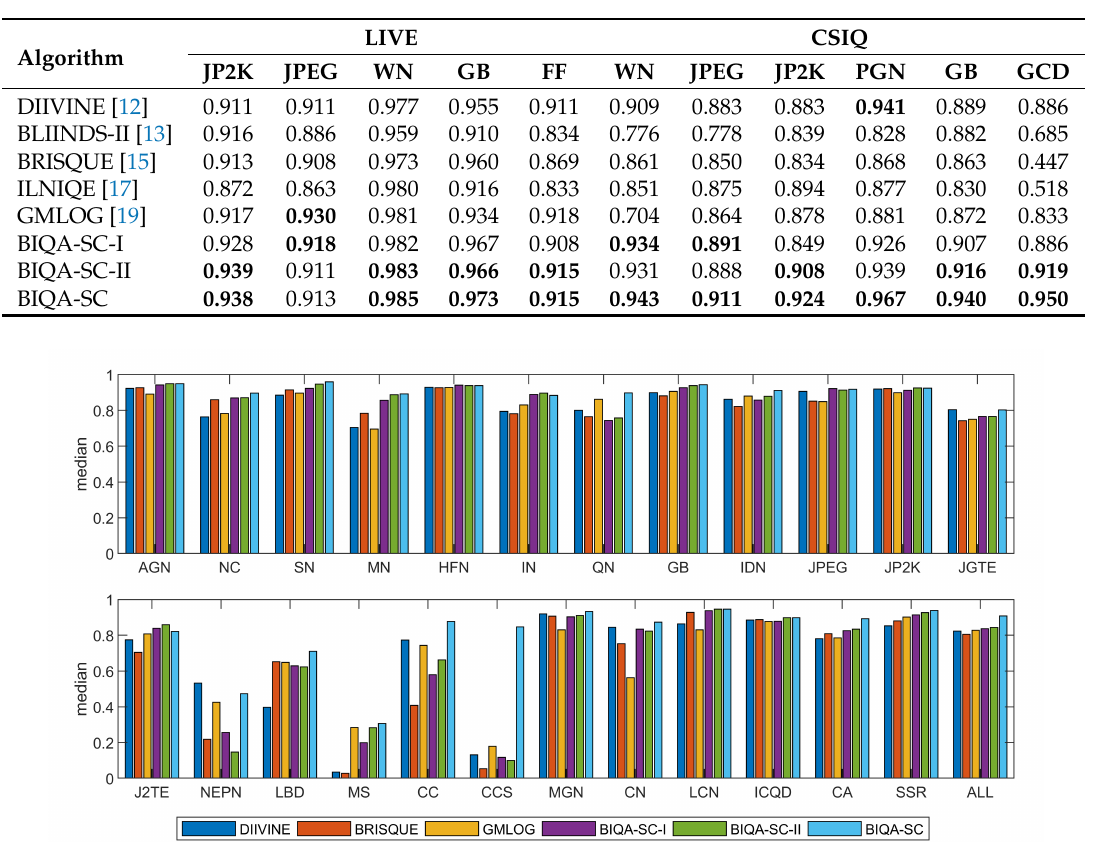
Table 4. Median SROCC comparison of the competing algorithms on individual distortion types in LIVE [28] and CSIQ [29] databases. The distortion types include additive Gaussian white noise (WN), JPEG compression (JPEG), JPEG2000 compression (JP2K), Gaussian blur (GB), fast fading (FF), pink Gaussian noise (PGN), and global contrast decrements (GCD). The best two algorithms are highlighted in boldface.